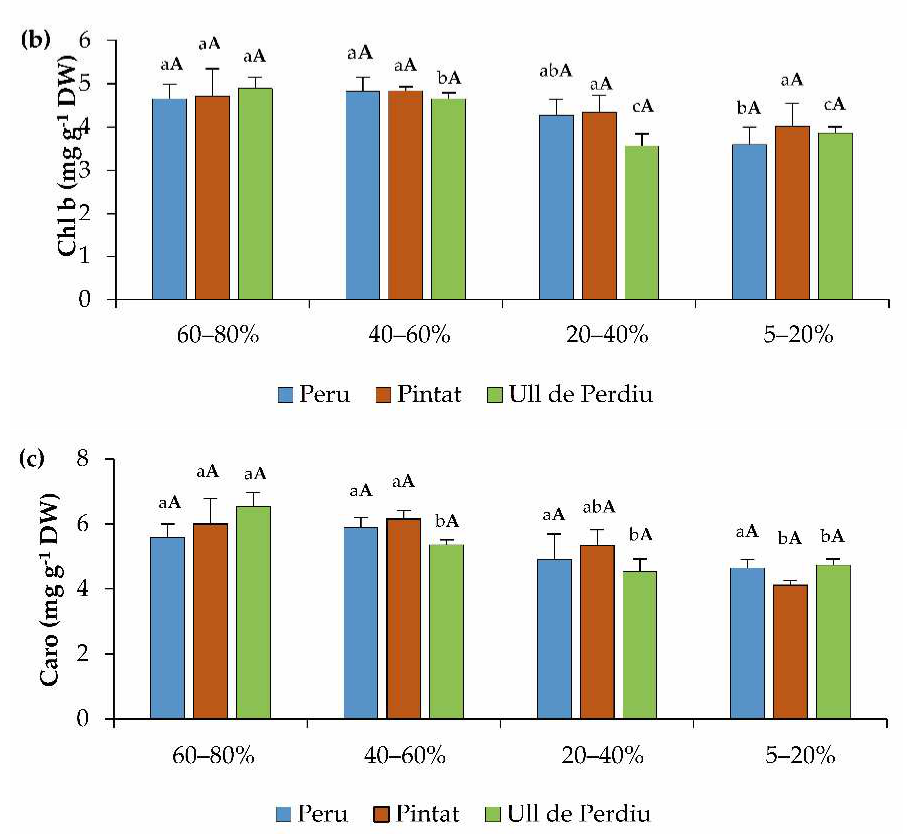
Figure 4. Chlorophyll a (Chl a) ( a ) chlorophyll b (Chl b) ( b ) and carotenoid (Caro) ( c ) contents in leaves of the three Phaseolus lunatus cultivars. Lowercase letters indicate significant differences within each cultivar and uppercase letters (in bold) between cultivars, but within treatments, according to Tukey’s test (α = 0.05). p values according to one-way ANOVA.